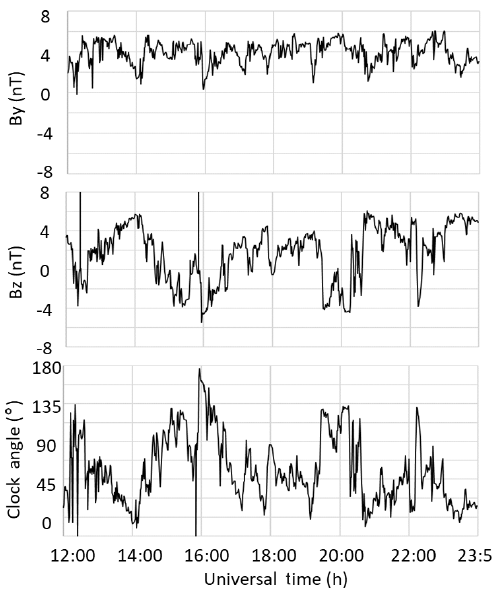
Figure 1. The y and z components of the IMF, and the clock angle observed by the ACE spacecraft between 12:00 and 23:59UT on 17 December 2014. The data have been time-shifted to the nose of the Earth’s bow